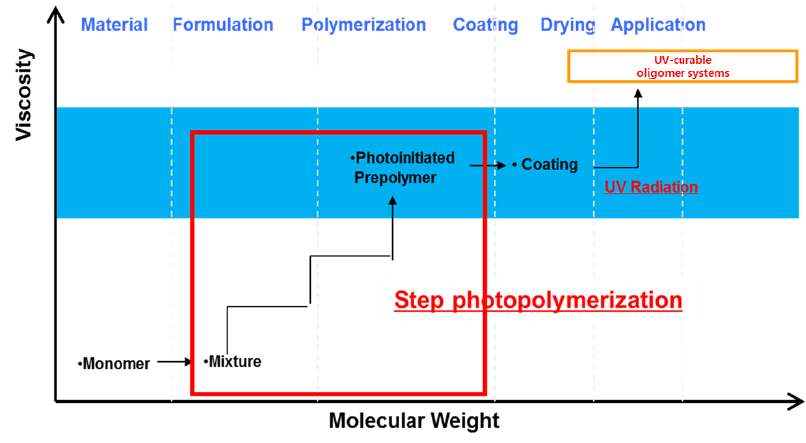
Figure 1. Status of ultraviolet (UV)-polymerized oligomers during various stages of the polymerization process.